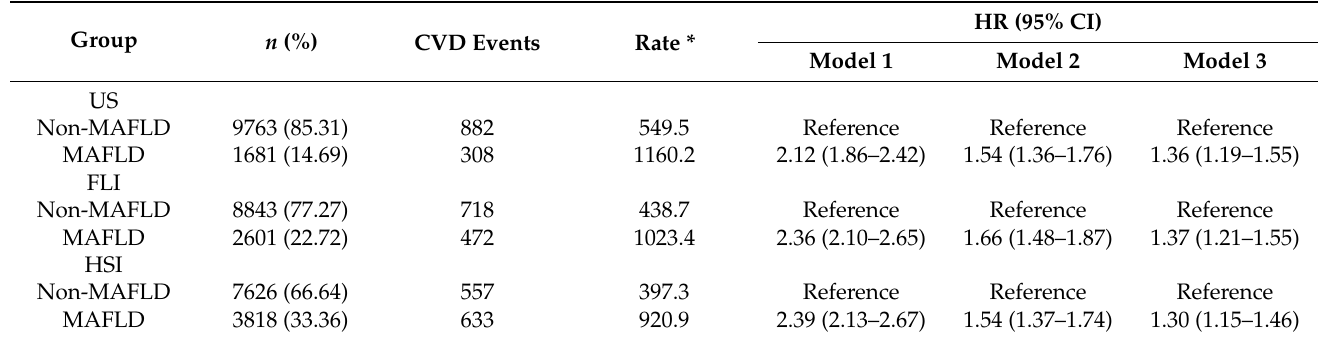
Table 2. Cox regression model of the relationship between cardiovascular disease and metabolic dysfunction-associated fatty liver disease diagnosed using different steatosis models.